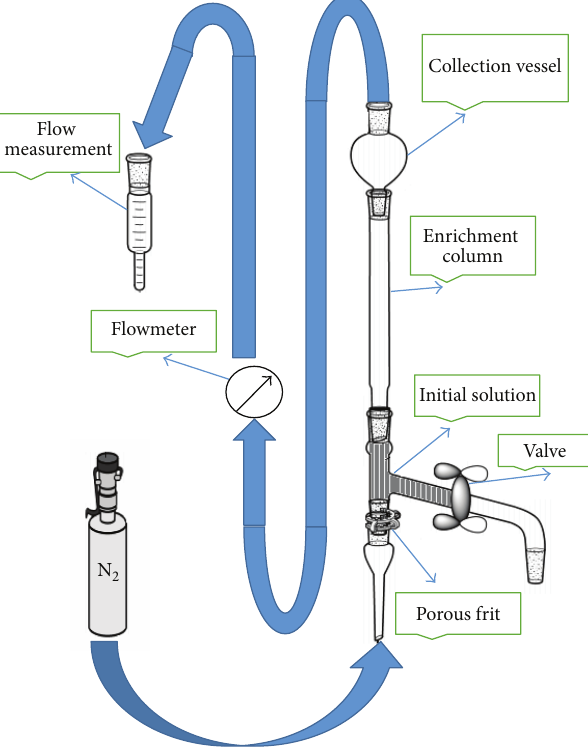
Figure 1: Scheme of the Adsorptive Bubble Separation